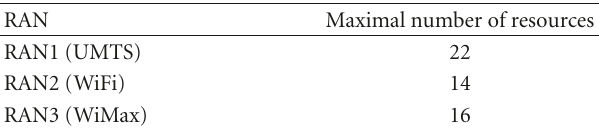
Table 1: Maximal capacities of used RANs. RAN Maximal number of resources